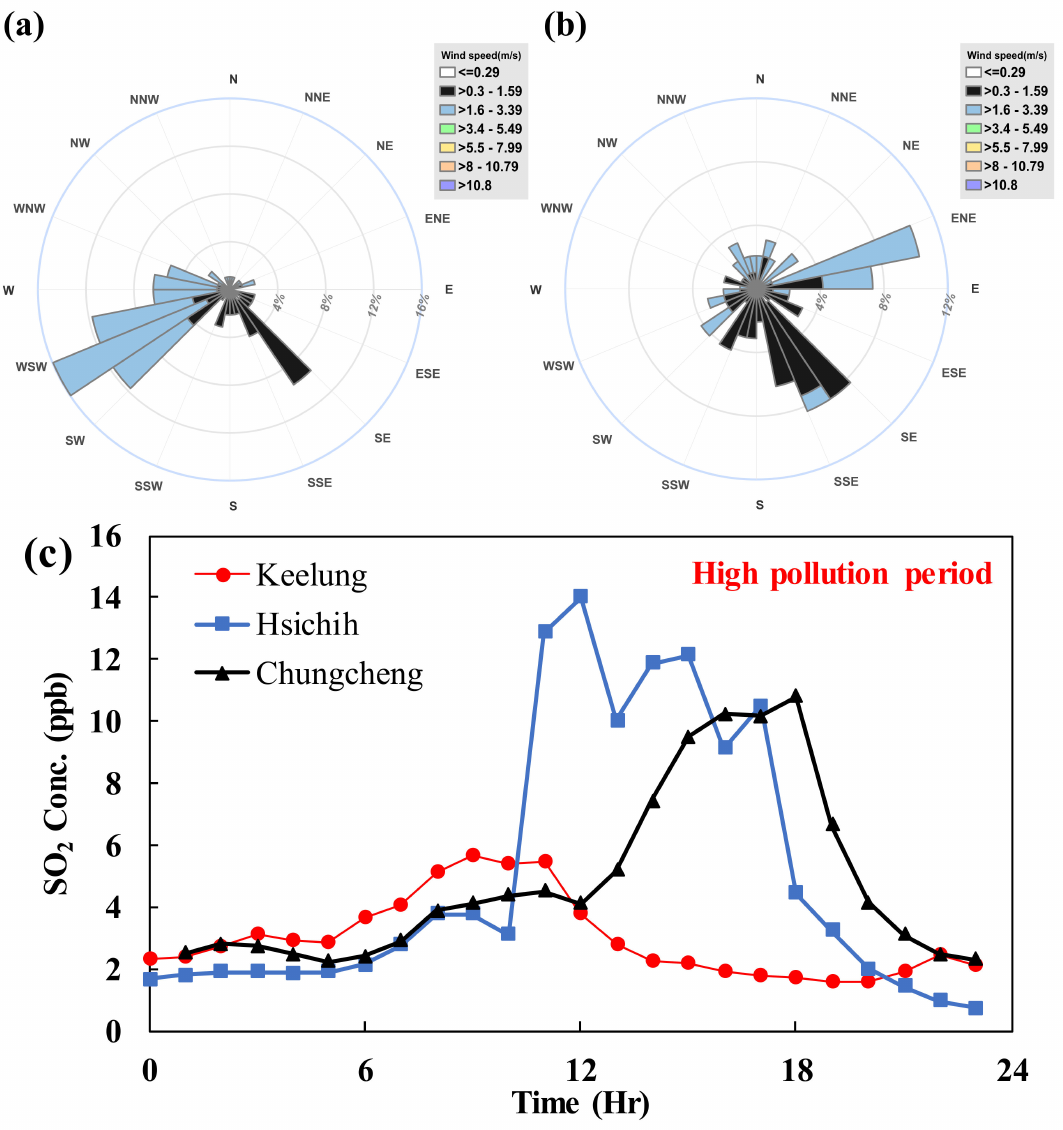
Figure 11. Transport diagram. Wind field during ( a ) Sampling period, ( b ) Episode days, and ( c ) SO 2 at different